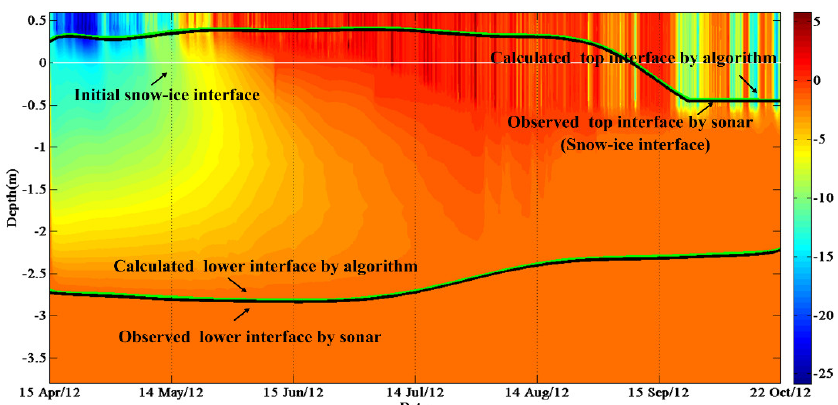
Figure 6. Sea ice temperature contours from 15 April to 23 October 2012 measured by IMB-2012B. The black lines are observed top and lower interfaces. The green lines are calculated top and lower interfaces. The white lines are initial snow-ice interfaces.